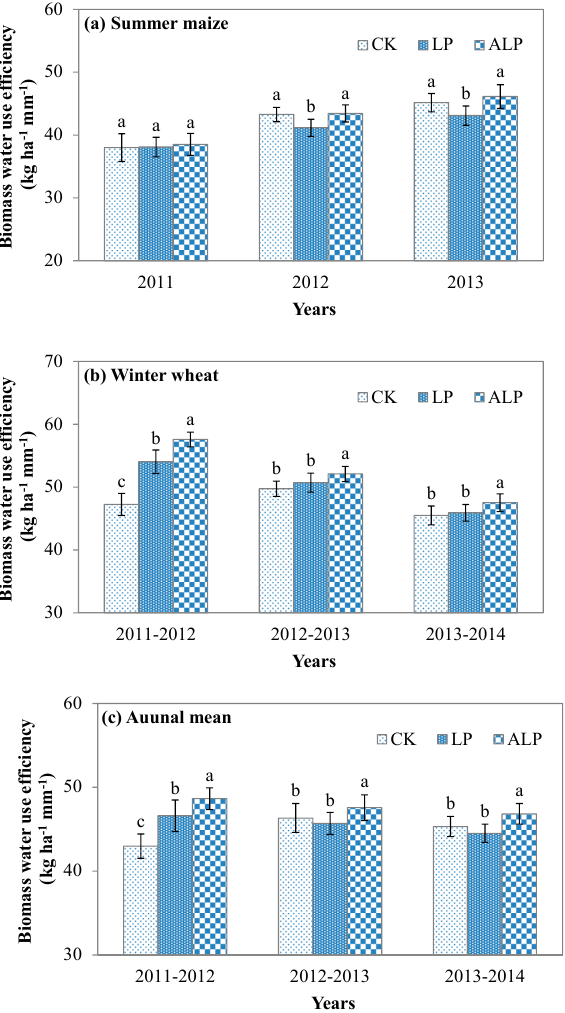
Figure 2. Effects of straw incorporation treatments on biomass water use efficiency in winter wheat season, summer maize season and annual maize and wheat season. Bars with the same letter for the same year are not different at p = 0.05. CK indicates long straw (5 cm) mulching with N fertilizer. LP indicates long straw with N fertilizer plowed into the soil. ALP indicates ammoniated long straw with N fertilizer plowed into the soil.